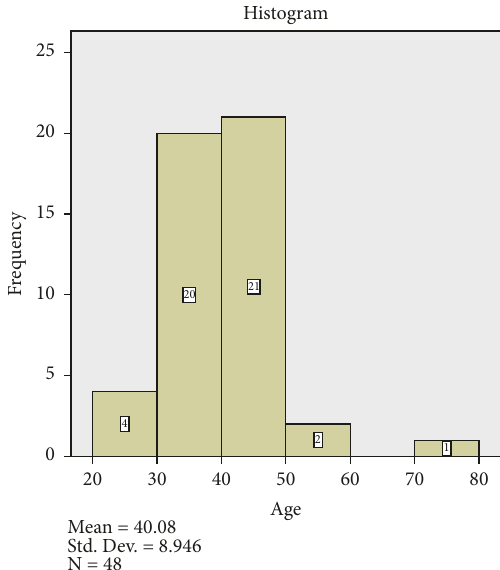
Figure 4: Histogram of cases of endometrial polyp. It shows the preponderanceof cases of endometrial polyp in the age group of 30- 50 years.